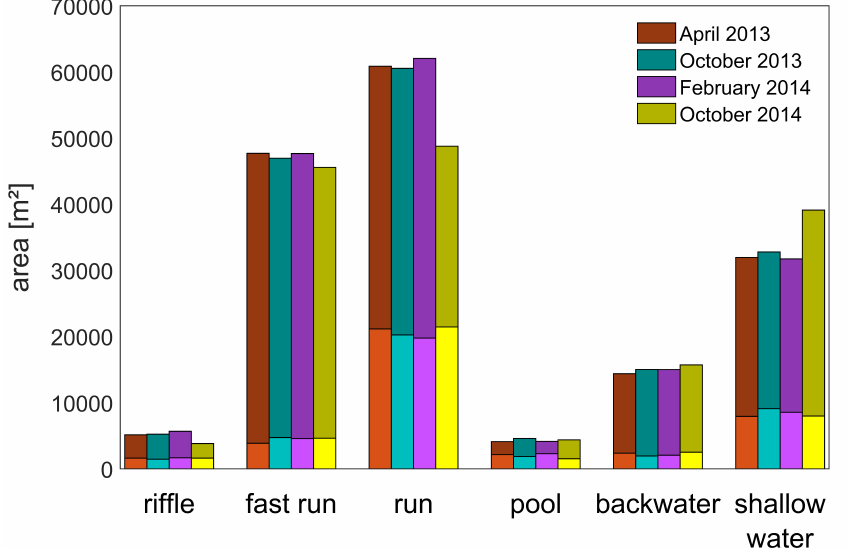
Figure 14. Variability of area distribution of hydro-morphological units in the period April 2013–October 2014 analyzed for mean flow (7.16 m 3 · s − 1 , lower part of the bars) and annual flood (136.6 m 3 · s − 1 , entire bars)